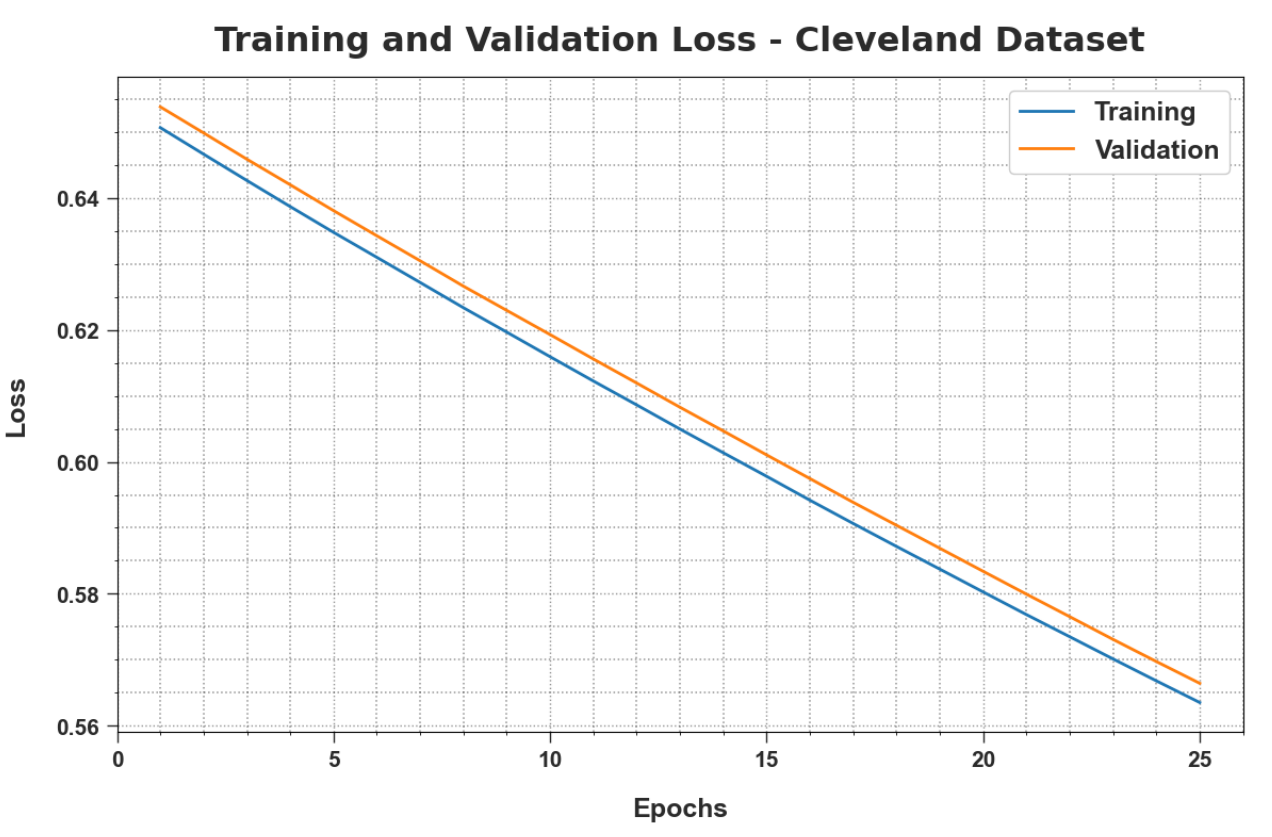
Figure 7. 𝑇𝑅 𝑙𝑜𝑠𝑠 and 𝑉𝐿 𝑙𝑜𝑠𝑠 analysis results of the MLMDMC-ED algorithm on the Figure 7. TR loss and VL loss analysis results of the MLMDMC-ED algorithm on the Cleveland Cleveland dataset